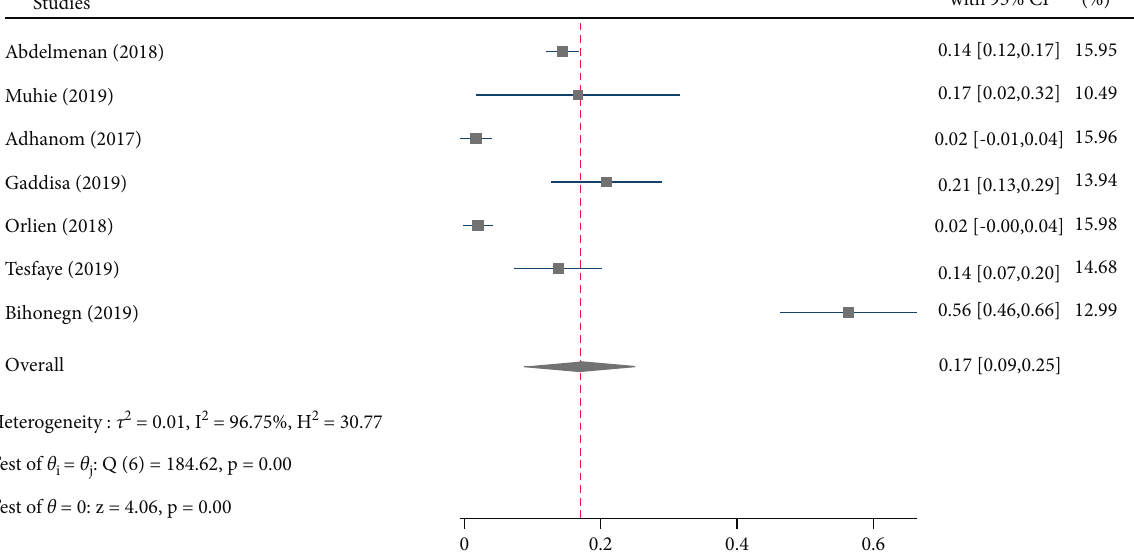
Figure 8: Forest plot depicting the estimated proportion of alcoholic hepatitis among chronic liver disease patients in Ethiopia, 2021. Table 4: Estimated proportion of chronic liver disease etiologies and heterogeneity of the estimates in Ethiopia, 2021. Etiologies of CLD No. of studies Sample size